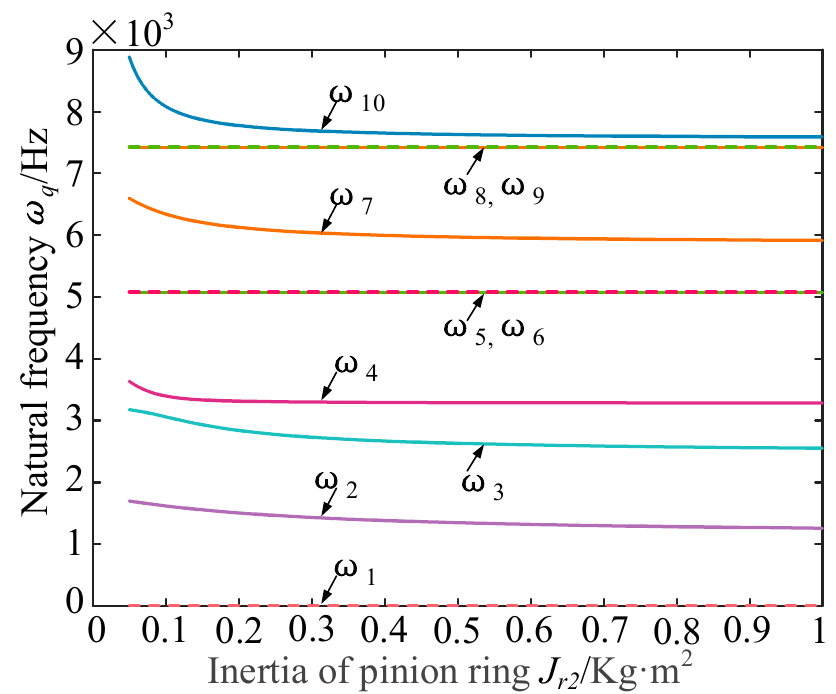
Figure 14. The trajectory of the natural frequency with (cid:1836)